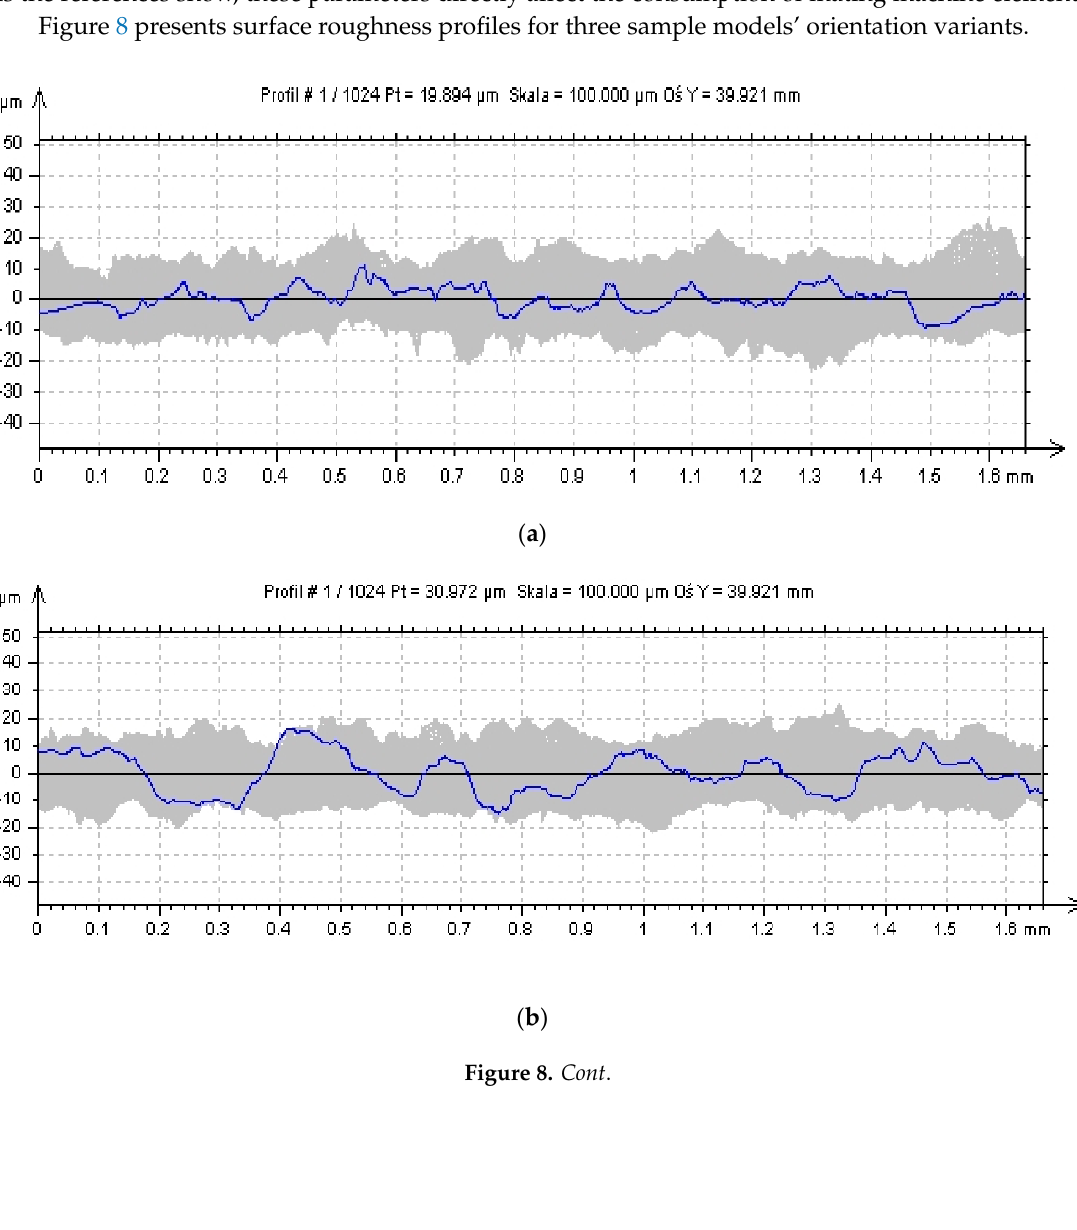
Figure 7. Relative values of surface parameters for printing orientation 90°.